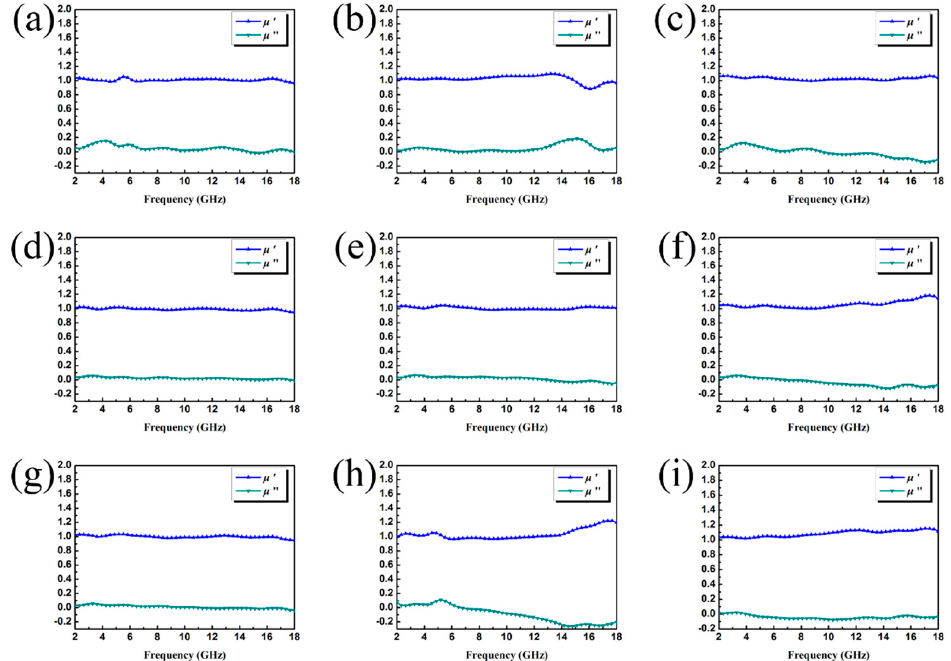
Figure 8. Frequency dependence of real and imaginary parts of complex permeability of sample A with a filler loading of ( a ) 20 wt%, ( b ) 30 wt%, ( c ) 40 wt%; sample B with a filler loading of ( d ) 20 wt%, ( e ) 30 wt%, ( f ) 40 wt%; sample C with a filler loading of ( g ) 20 wt%, ( h ) 30 wt%, ( i ) 40 wt%.